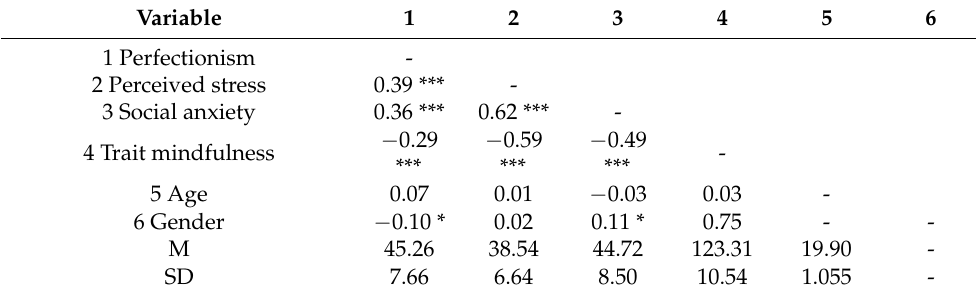
Table 1. The mean (M), standard deviation (SD), and correlations of the variables (n = 425).